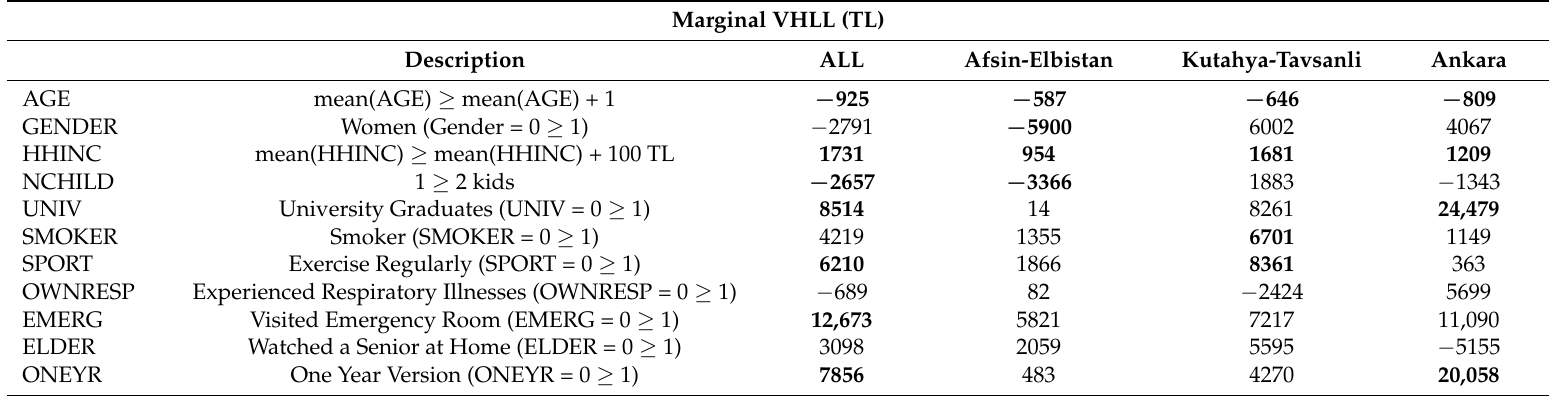
Table 9. Marginal VHLL based on Model 2.